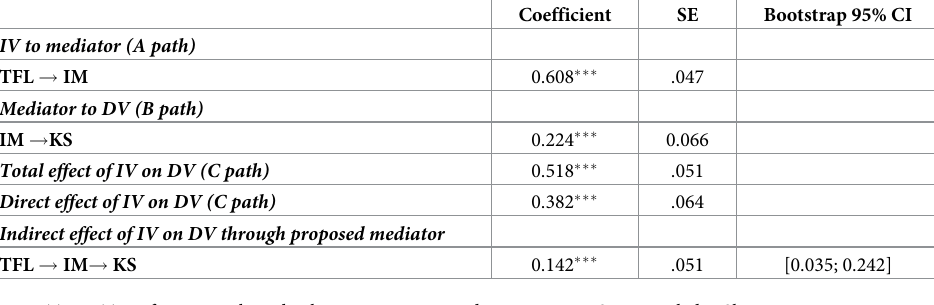
Table 5. Results of the mediation analyses of TFL, IM, and KS (without